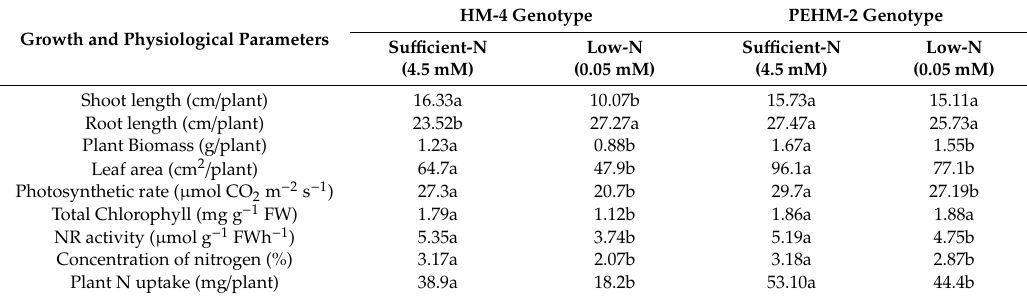
Table 1. Growth and physiological parameters of low-N sensitive (HM-4) and low-N tolerant